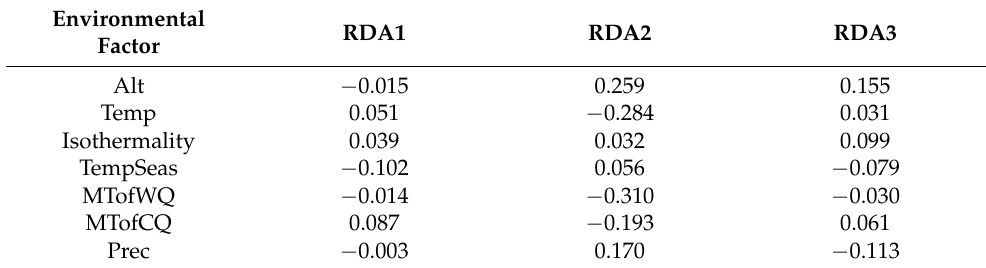
Table 2. Correlation of environmental factors with the first three RDA axes.